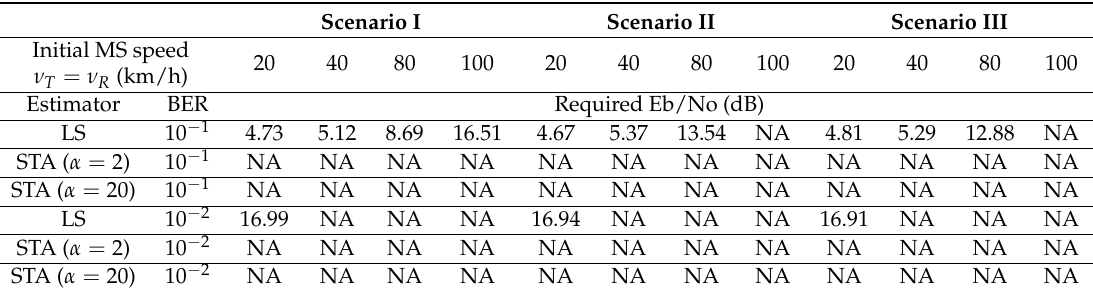
Table 5. Required energy per bit-to-noise spectral density ratio (Eb/No) levels to attain 10% and 1% BER over Scenarios I, II, and III at different initial speeds by considering acceleration components